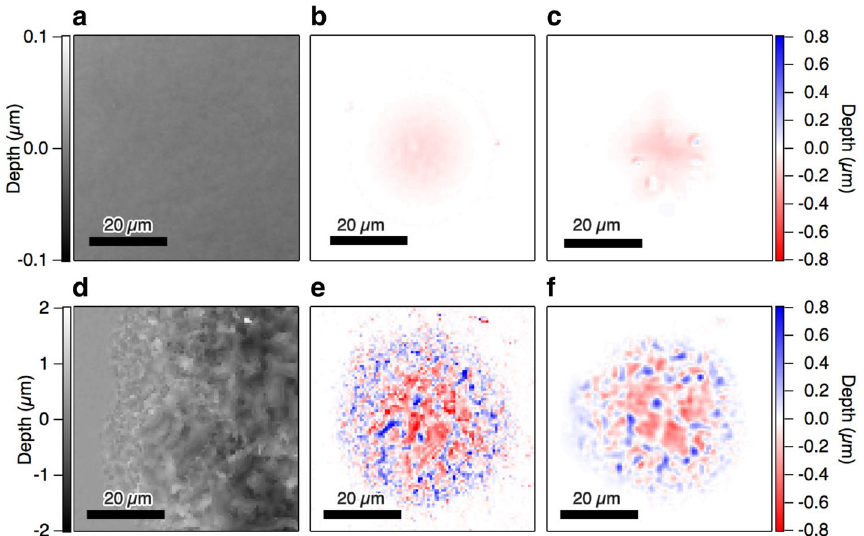
Figure 2. Comparison of experiments with simulations for single-shot irradiation. ( a – c ) Evaluation of an intact surface, ( d – f ) Evaluation of a laser-irradiated surface. ( a , d ) Depth profiles before irradiation. ( b , e ) Changes in depth profiles obtained experimentally. ( c , f ) Changes in depth profiles calculated using the simulator. A silicon substrate was used as the test target. The pulse energy for each evaluation was 40